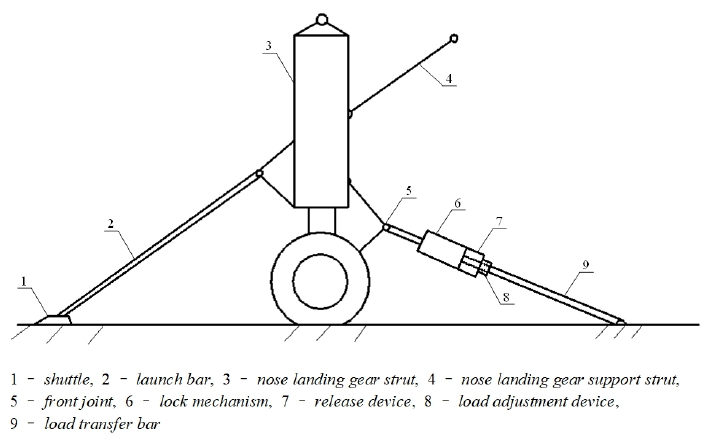
Figure 3. Schematic diagram of the connection between the holdback bar and the nose landing gear and the